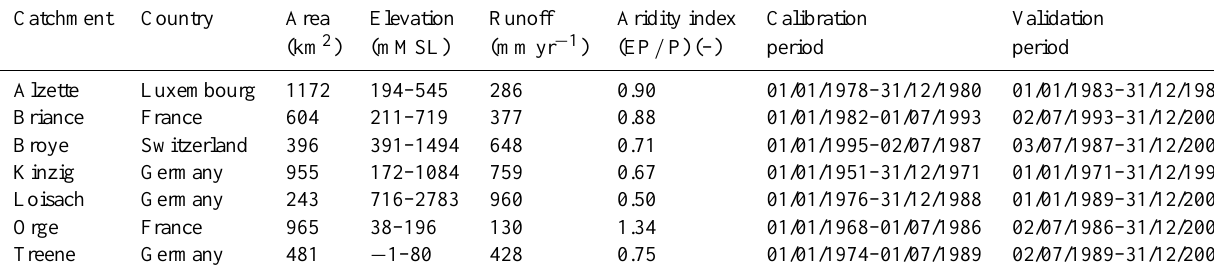
Table 1. Overview of the catchments.